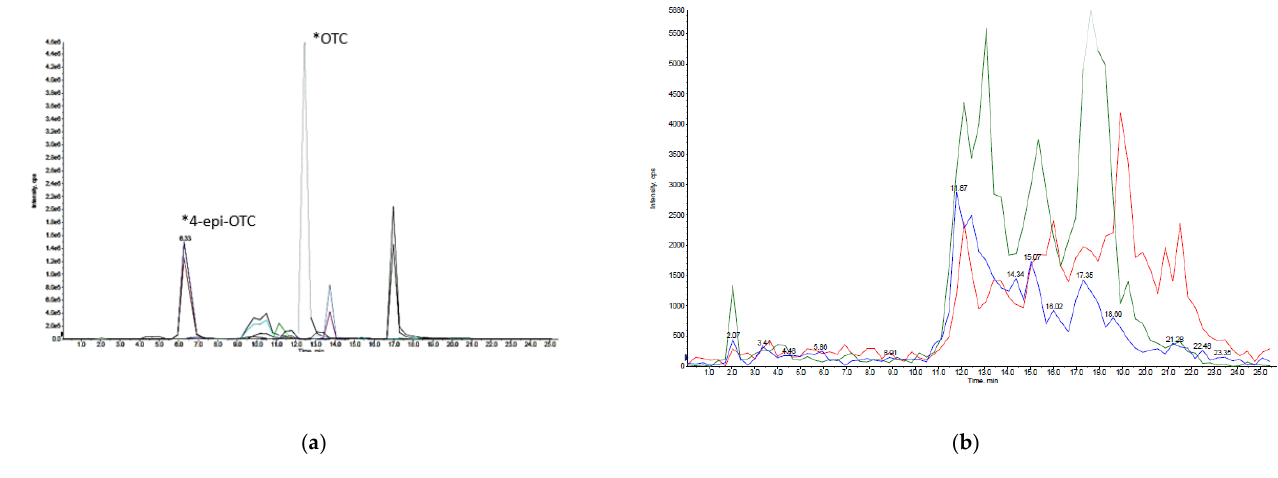
Figure 3. Representative chromatograms of the ( a ) injection of a certified standard of OTC and 4-epi-OTC (*: peaks) and from the analysis of ( b ) litter sample free of OTC and 4-epi-OTC.